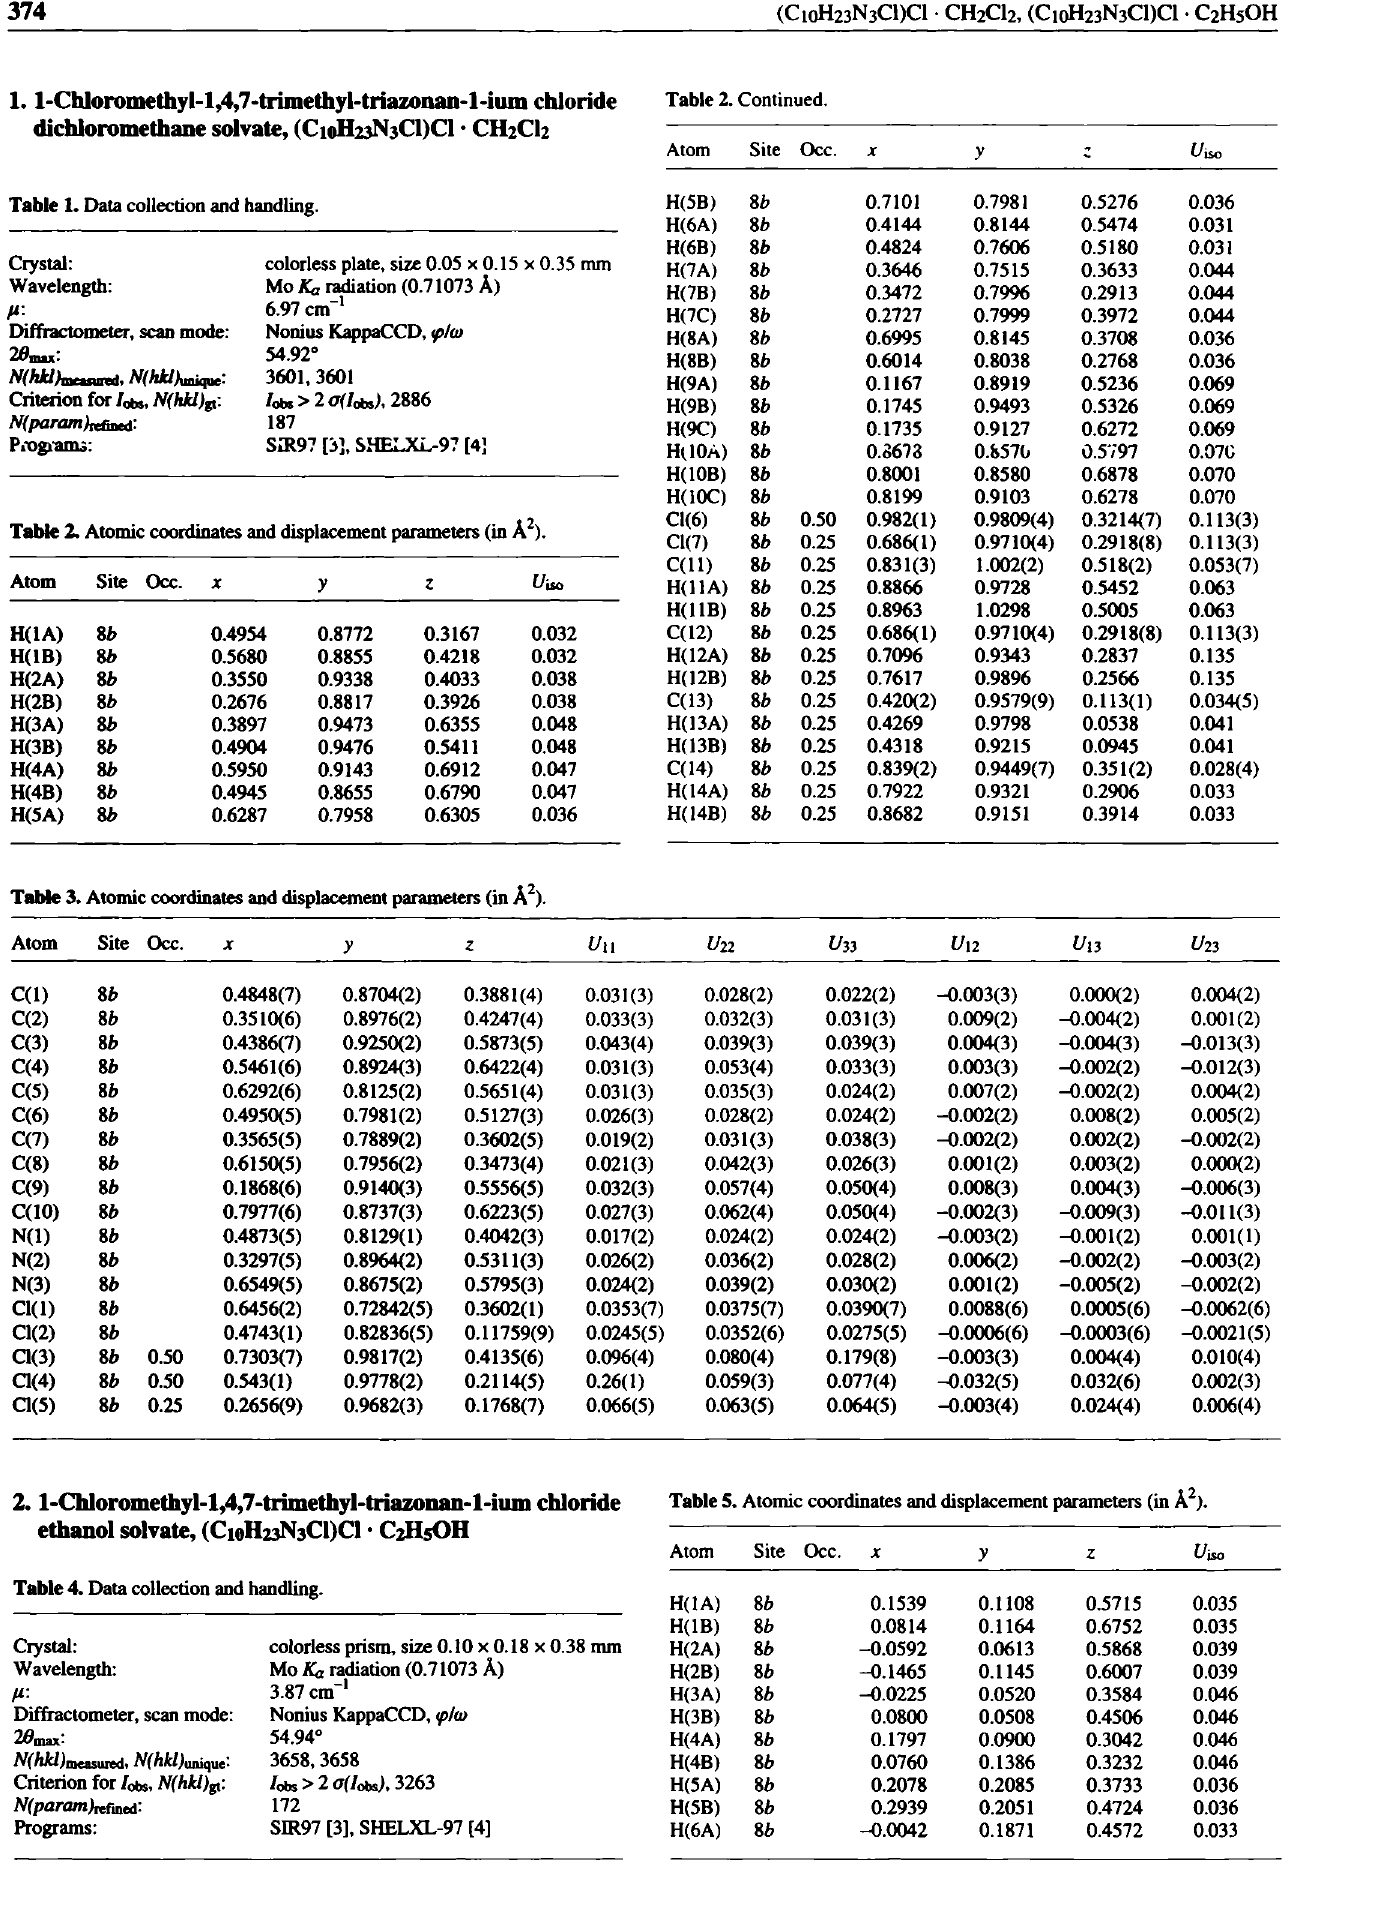
Table 4. Data collection and